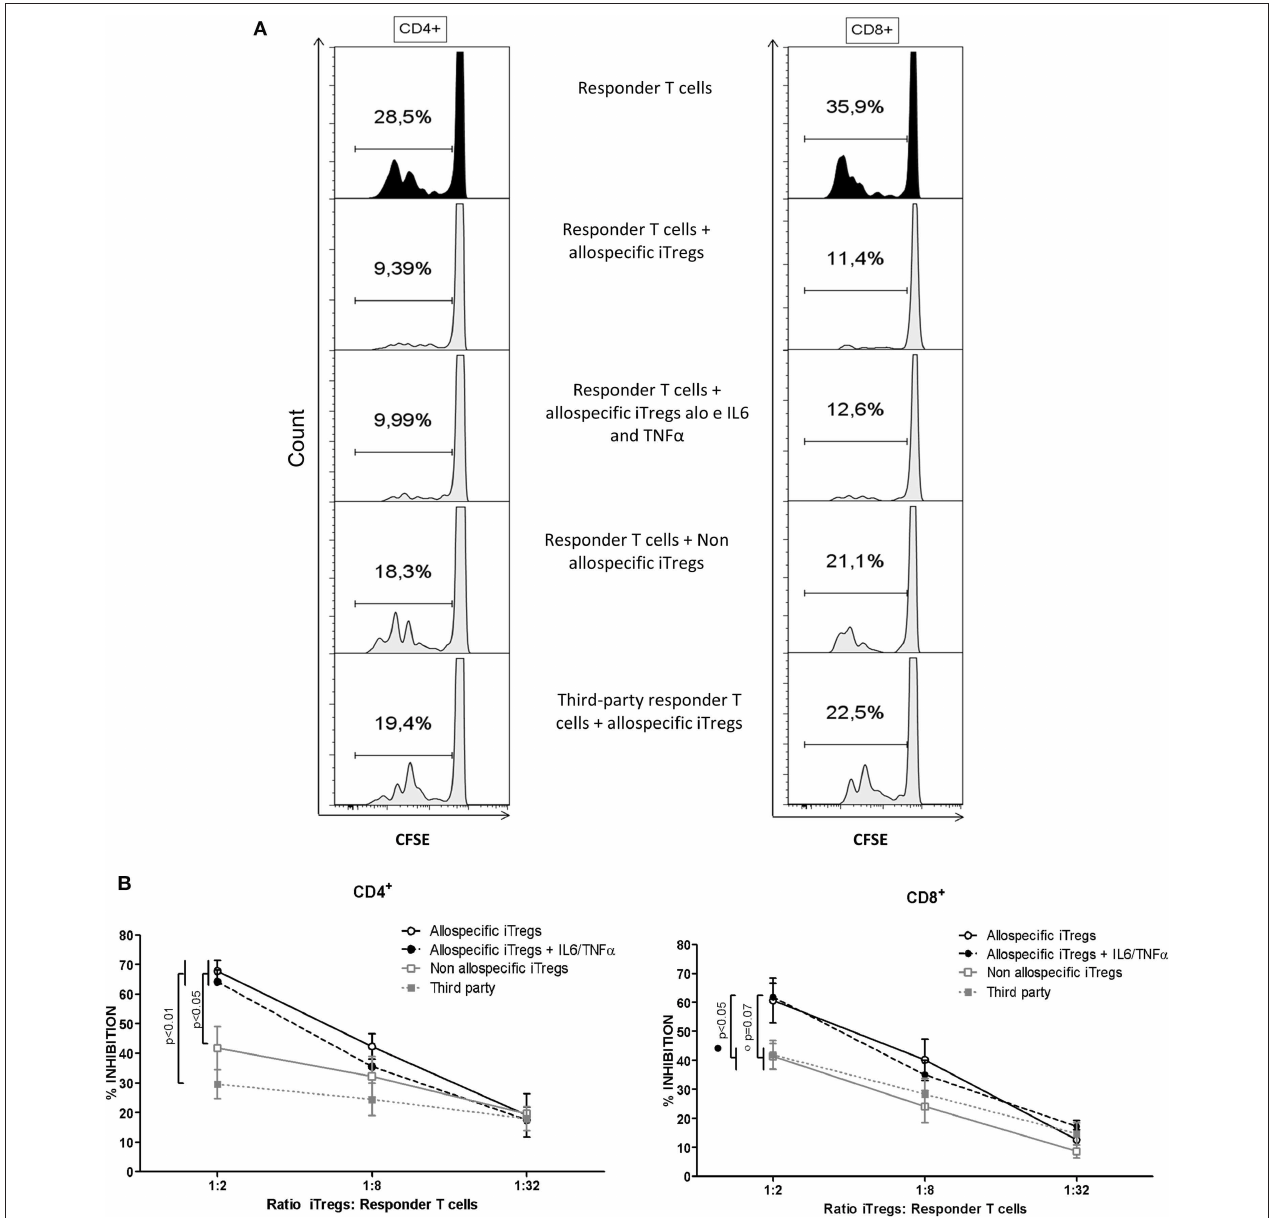
FIGURE 6 | Allospecific suppression mediated by long-term expanded iTregs is not affected by pro-inflammatory cytokines. Proliferating CD4 + CD25 ++ CTV − cells ( Figure 2 ) expanded for 4 weeks were stimulated for two additional weeks with IL-6/TNF α and were added to co-cultures of T cells/mo-DCs. (A) Histograms show the proliferation of CD3 + T cells in the absence (responder T cells) or the presence of the allospecific expanded iTregs without the addition of cytokines during polyclonal expansion (responder T cells + allospecific iTregs) or with the addition of the cytokines IL-6 + TNF- α during the next 2 weeks of expansion (responder T cells + allospecific iTregs and IL-6/TNF- α ). As controls, allospecific iTregs and stimulating DCs from unrelated individuals (third-party responder T cells) were considered. The numbers indicate the percentage of proliferation, when iTregs:responder T cells are put into the proportion of 1:2. (B) Graph showing the percentage of inhibition of the proliferation of responder T cells (CD3 + CD4 + and CD3 + CD8 + ) against the different conditions mentioned and into different proportions of iTregs:T responders. Suppression was calculated as relative inhibition using the following formula: [(Tresp proliferation without Tregs – Tresp proliferation with Tregs)/Tresp proliferation without Tregs] × 100. Each dot indicates the mean ± SEM from n = 5 donor from three independent experiments of each condition tested. Statistical analysis was performed using non-parametric Mann–Whitney test, two-tailed. P < 0.05 was considered statistically significant.